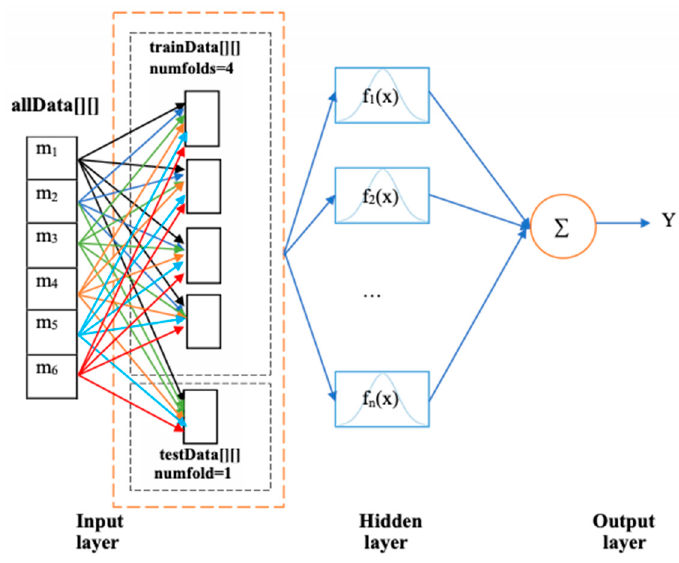
Figure 2. The structure of an RBFNN